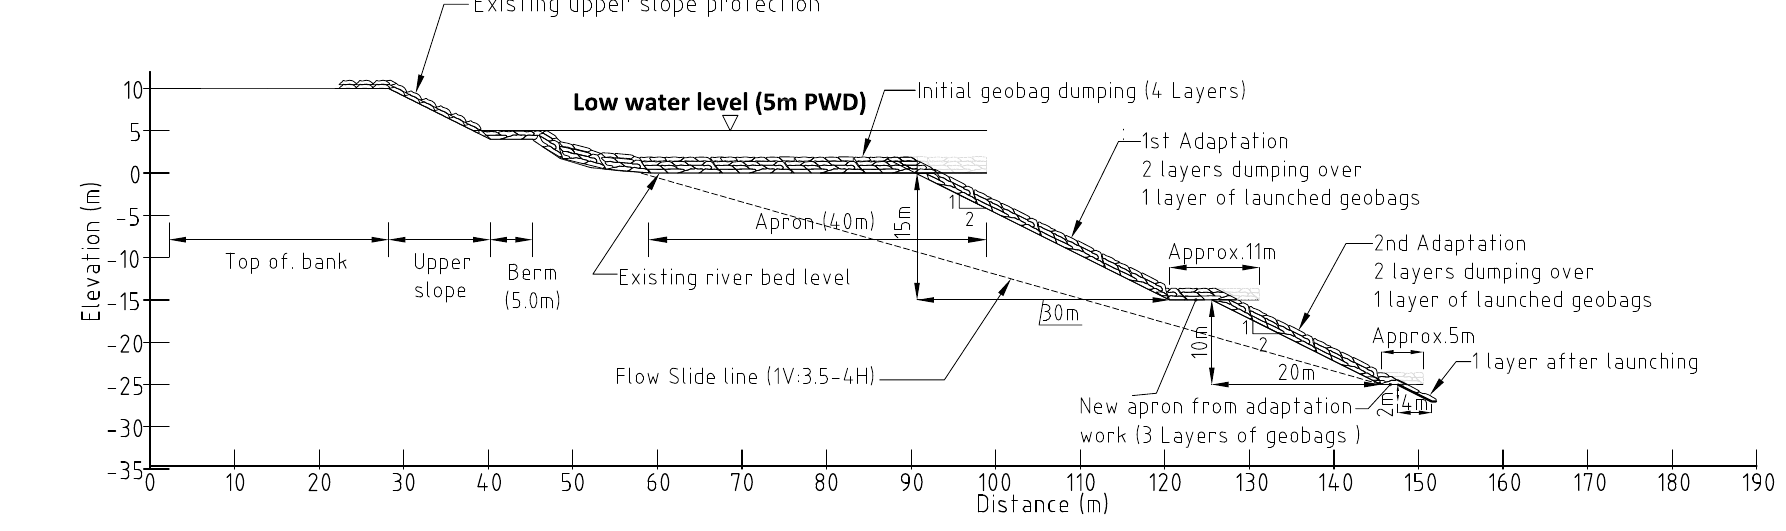
Figure 10. Adaptive riverbank protection for a wide apron and consolidated bank and unconsolidated bed